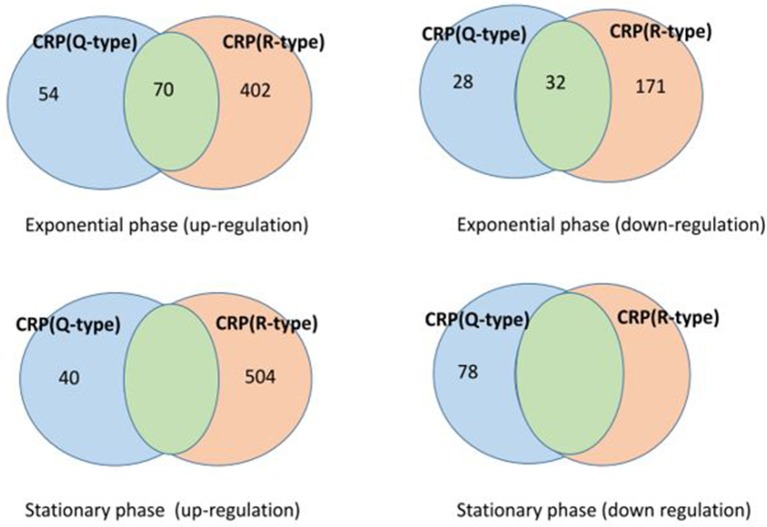
Venn diagram showing the disaggregation of the differential genes corresponding to each of the CRP mutants (Q-type: acetylated form, R-type: deacetylated form) according to the batch culture phase (exponential or stationary). The blue areas in the diagrams correspond to genes that depend exclusively on the Q-type, while the pink areas correspond to the genes that depend exclusively on the R-type. Importantly, the green regions correspond to common genes that can be influenced by both types of CRP mutants.